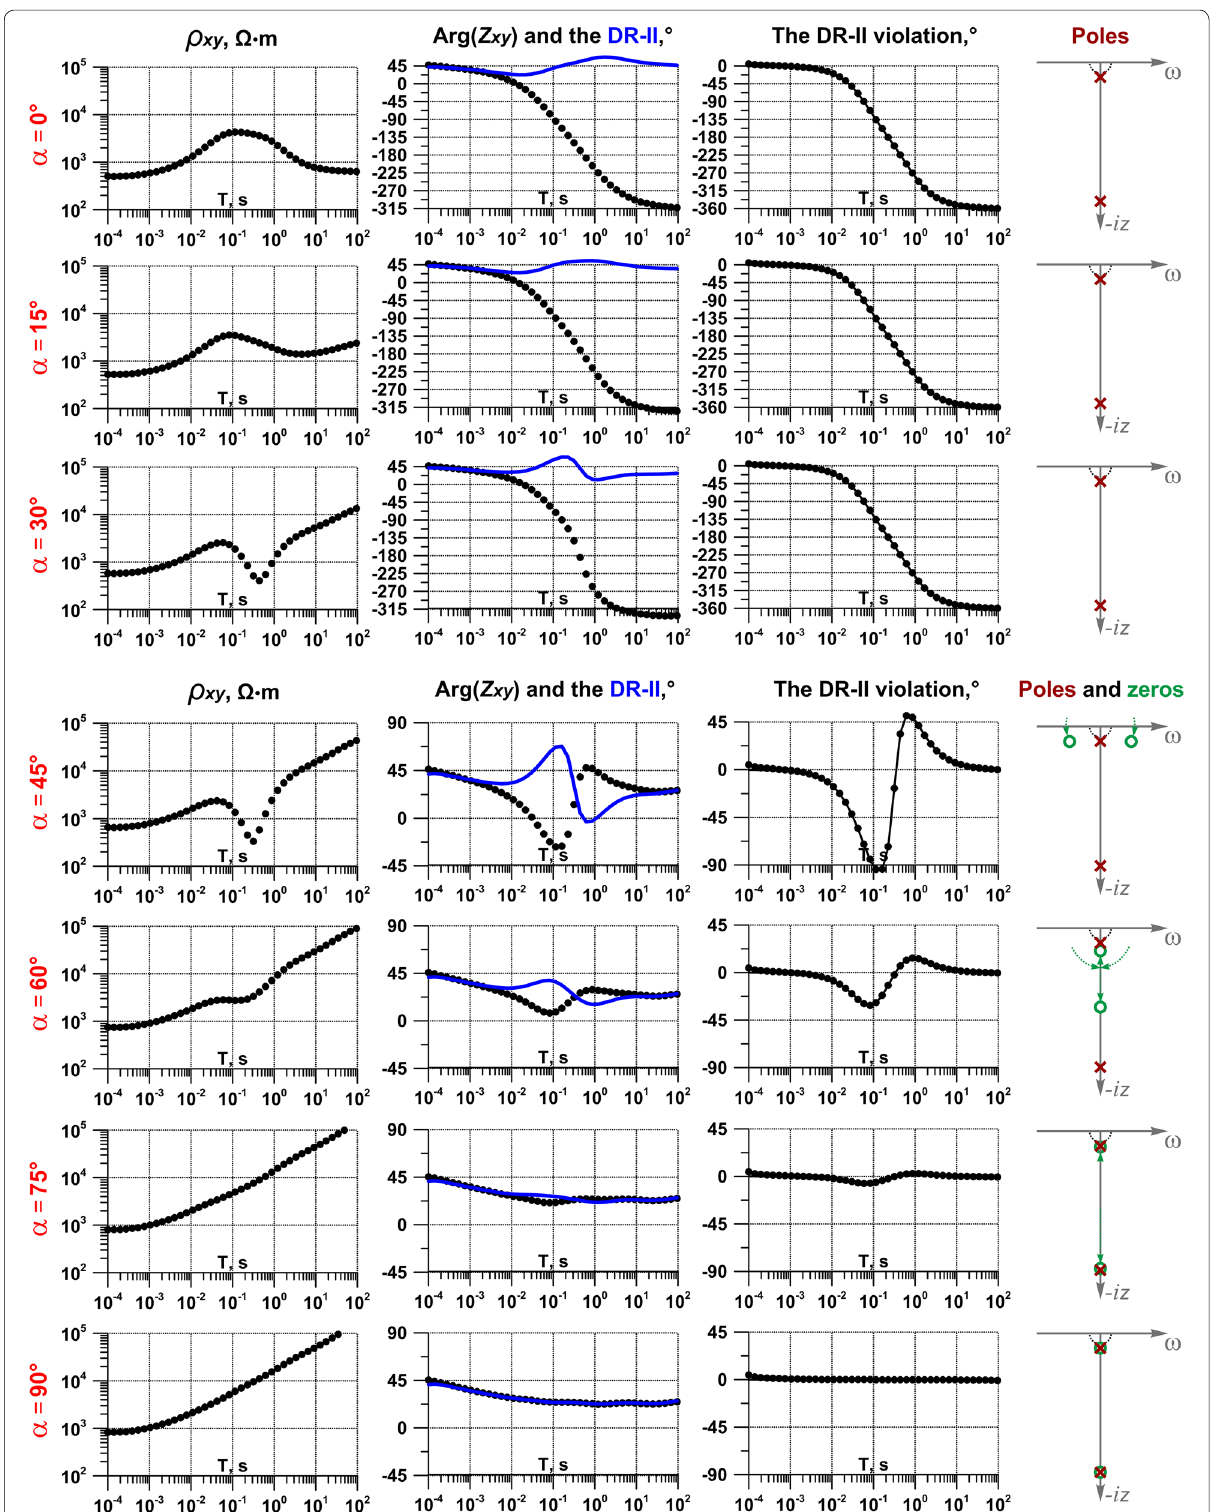
Fig. 7 The DR-II violation in Z xy for different values of the coordinate system rotation angle α . Red crosses and green circles in the right denote the revealed lower half-plane poles and zeros of Z xy ,